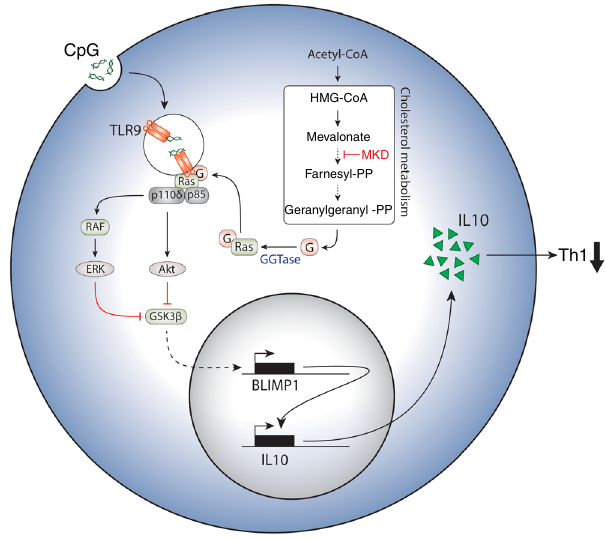
Fig. 7 B cell IL-10 regulation by GGPP. IL-10 production by B cells is regulated by cholesterol metabolism though geranylgeranyl pyrophosphate, controlling signaling cascades and BLIMP1 induction downstream of TLR9 engagement. MKD mevalonate kinase de fi